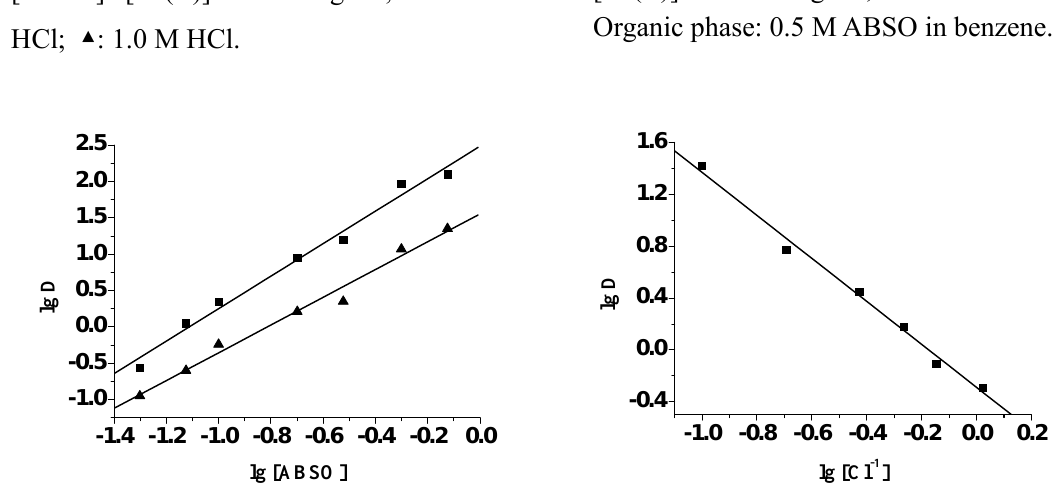
Figure 5 . Plot of Log D versus Log [Cl - ]. [Pd(II)] = 100 mg·L -1 ; HCl = 0.1 M; Organic phase: 0.5 M ABSO in